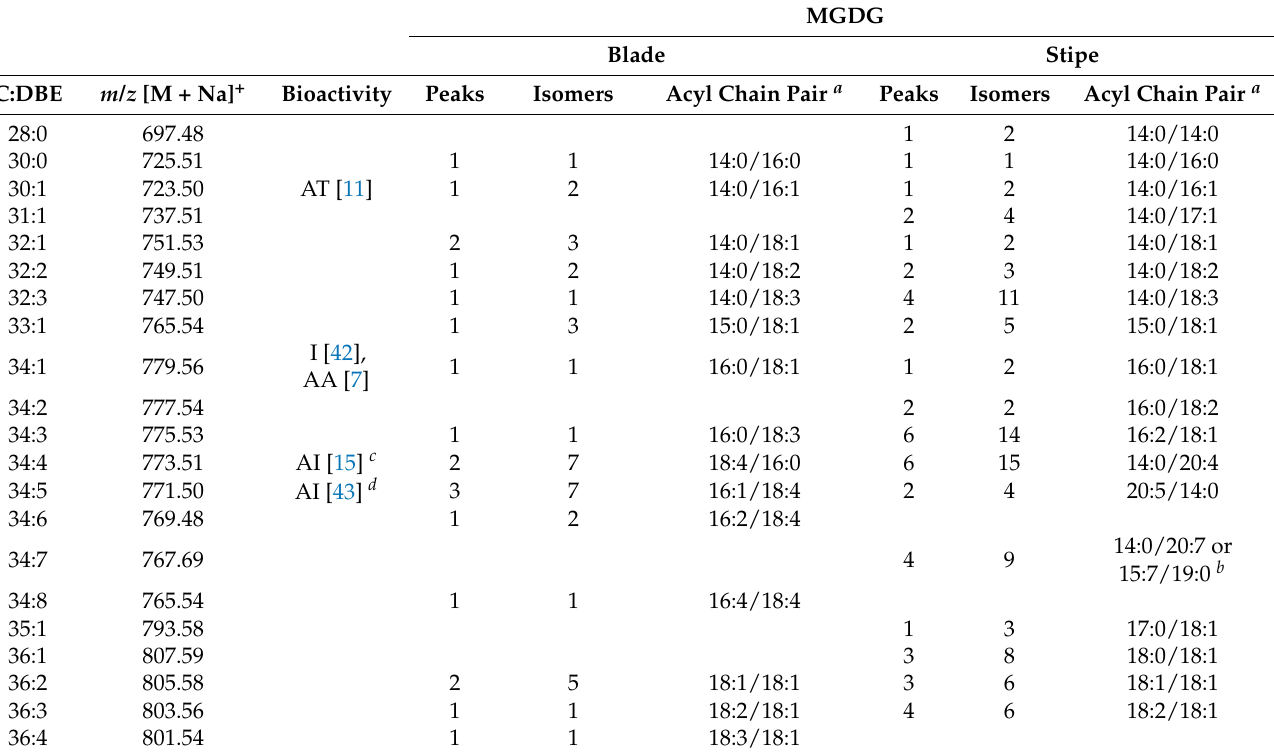
Table 1. Monogalactosyldiacylglycerol (MGDG) lipids identified in blade and stipe of Laminaria hyperborea . MGDG Blade